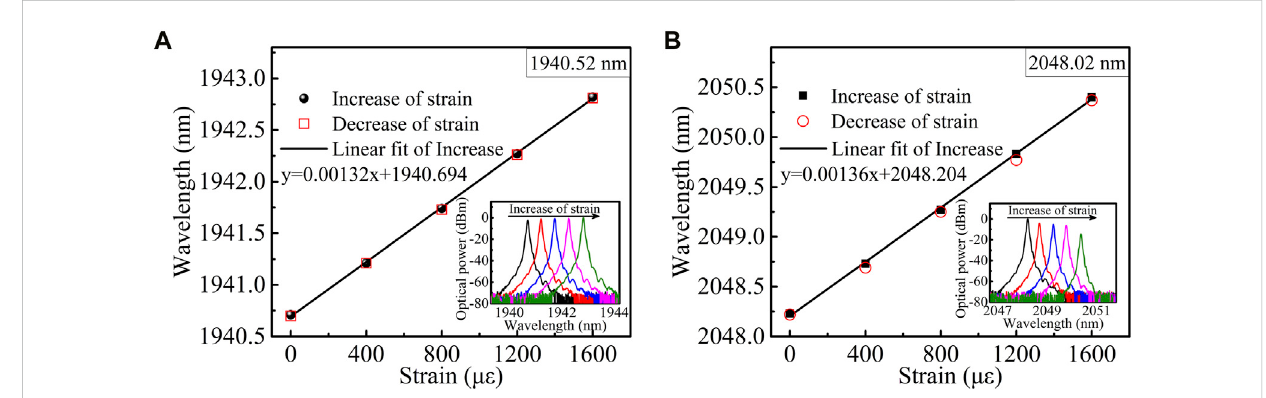
FIGURE 6 Small variations of output central wavelength as a function of strain when output wavelength is centered on (A) 1940.52 nm and (B) 2048.02 nm.